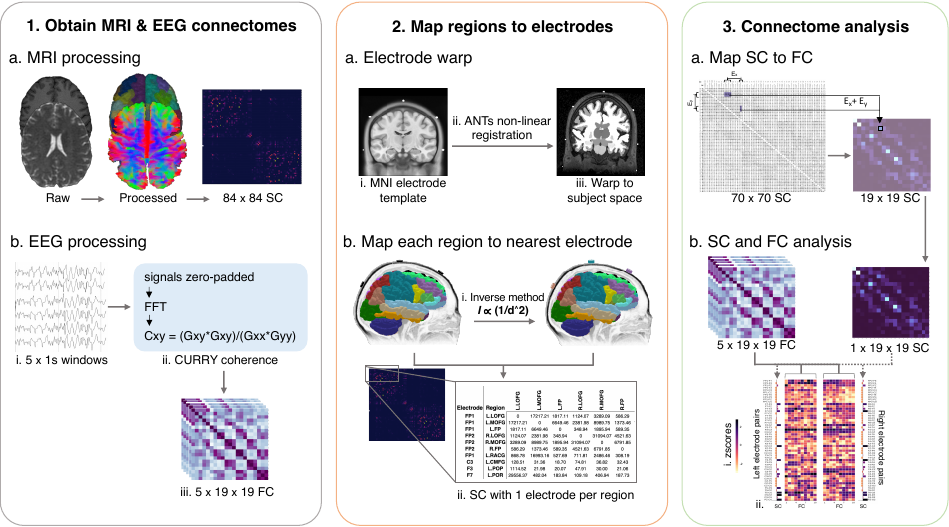
Figure 1. Schematic of data processing and analysis steps. To obtain the structural connectomes (“SC”, Step 1, a), the dMRI was processed, and anatomically-constrained probabilistic tractography was conducted as outlined in Section 2.3. Cortical regions of interest were based on the Desikan-Killiany (DK) [32] atlas. To obtain the functional connectomes (“FC”), the first 5 s of a given seizure were selected using one-second windows. Each one-second window was processed using Curry’s sensor coherence algorithm (Step 1, b, ii), producing a 21 × 21 coherence matrix. The reference electrodes were removed before statistical analysis, resulting in a 19 × 19 coherence matrix which was used as the functional connectome. In Step 2, the ANTs non-linear registration tool was used to warp electrodes in the MNI template space to the subject space, creating a subject-specific electrode warp (a, i–iii). To produce a subject-specific, one-to-one map of each cortical region to its nearest electrode, we applied our inverse square method (b, i). The inputs were each subject’s electrode warp and cortical region labels from Step 1. The result was a structural connectome with an electrode name corresponding to each of the 70 regions, i.e., F7/L.LOFG (b, ii). In Step 3 (a), the 70 × 70 structural connectome was condensed to match the dimensions of the functional matrix (19 × 19). Specifically, the values of all regions corresponding to a given electrode pair were summed, and the total value was used as the connectivity value for that same electrode pair in the new condensed structural connectome. Lastly, z-scores were computed for all connectivity values in the structural and functional connectomes (b, i,ii) and the statistical analysis was